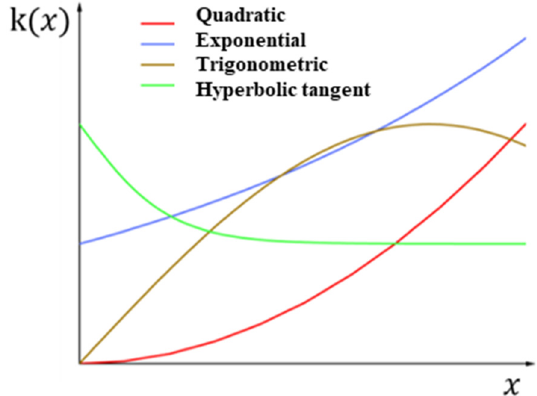
Figure 6. Physical parameter distribution along a certain direction for different functions.